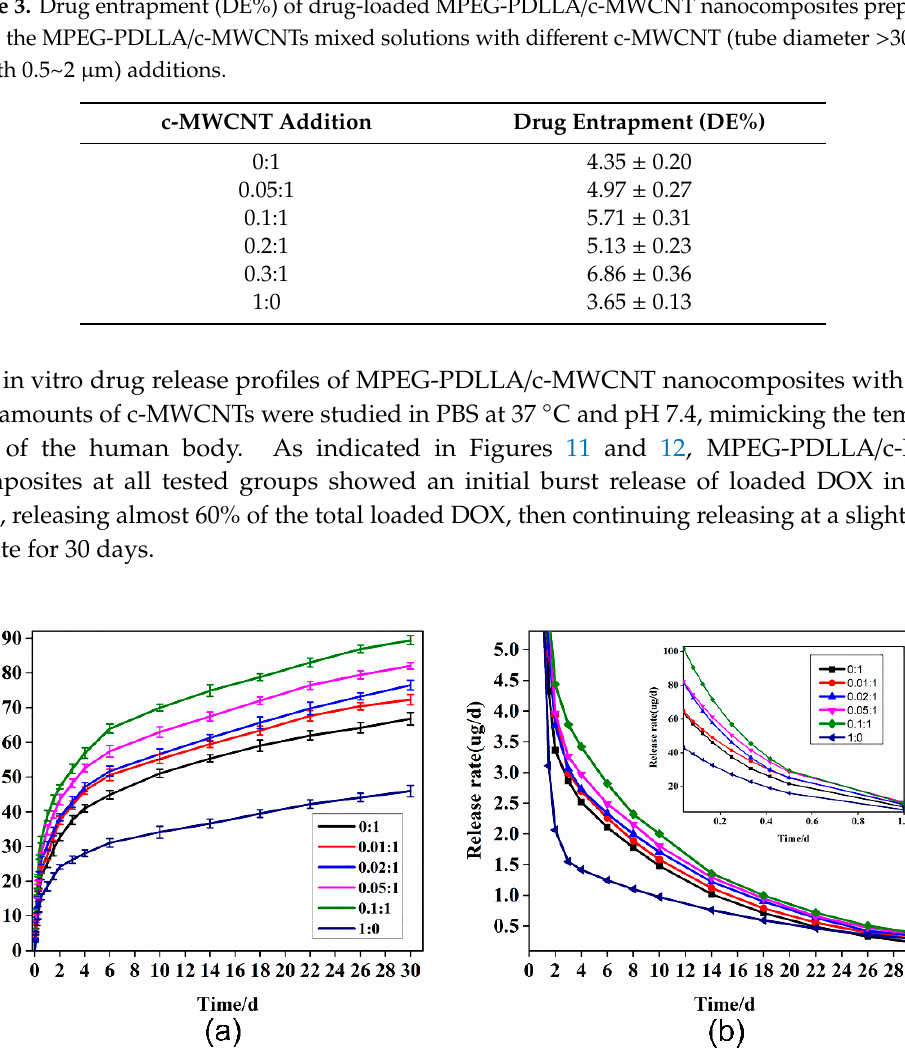
Figure 12. Release profiles of DOX from DOX-loaded nanocomposites prepared from the different addition amounts of c-MWCNTs (tube diameter 30~50 nm, length 0.5~2 μ m) in the MPEG-PDLLA/c-